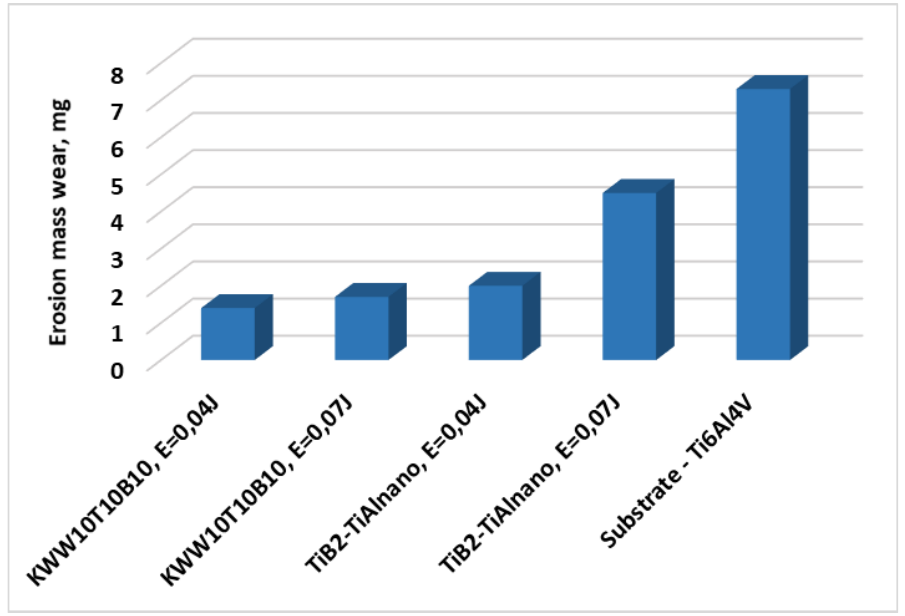
Figure 8. Mass loss of the tested coatings (erosive wear).